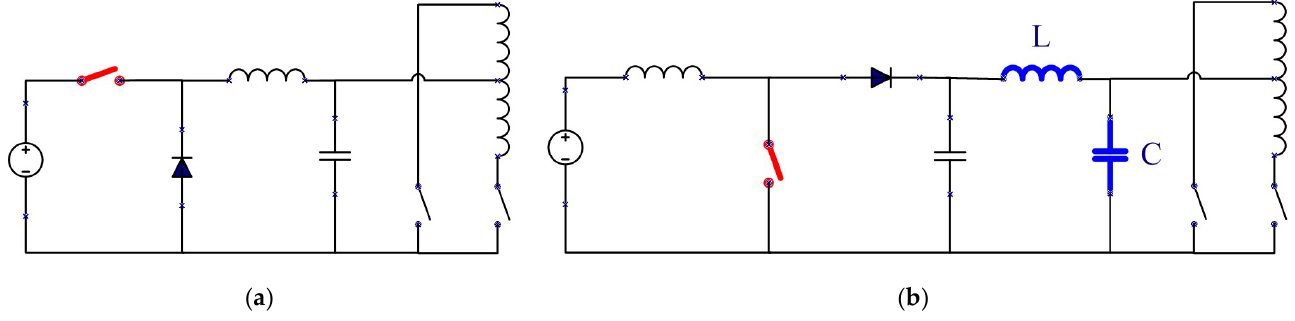
Figure 1. The two different topologies of a two-stage converter: ( a ) The buck and push–pull topology, and ( b ) the boost and push–pull topology.